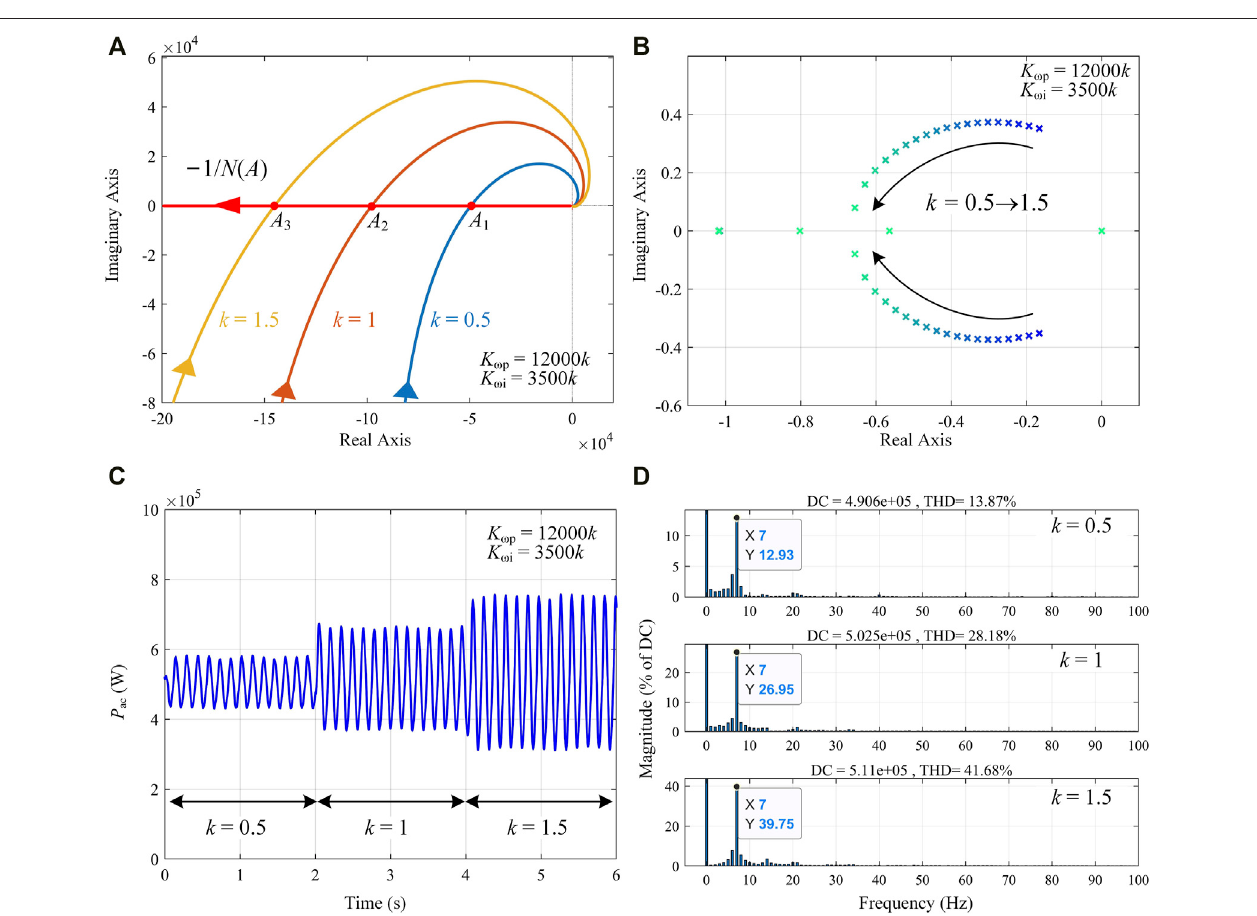
FIGURE 5 | Stability analyses and simulations when changing rotational-speed-loop parameters K ω p and K ω i . (A) Stability analyses based on the DF method considering the power control loop. (B) Stability analyses based on the poles of G 1 without considering the power control loop. (C) Power output. (D) FFT analyses.